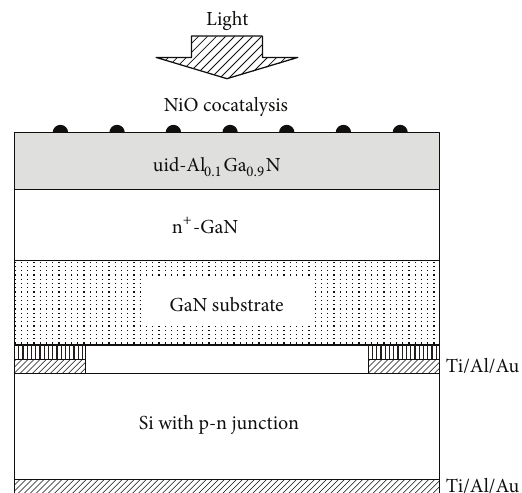
Figure 1: The photoelectrode structure, consisting of an AlGaN/ GaN region and Si with p-n junction.